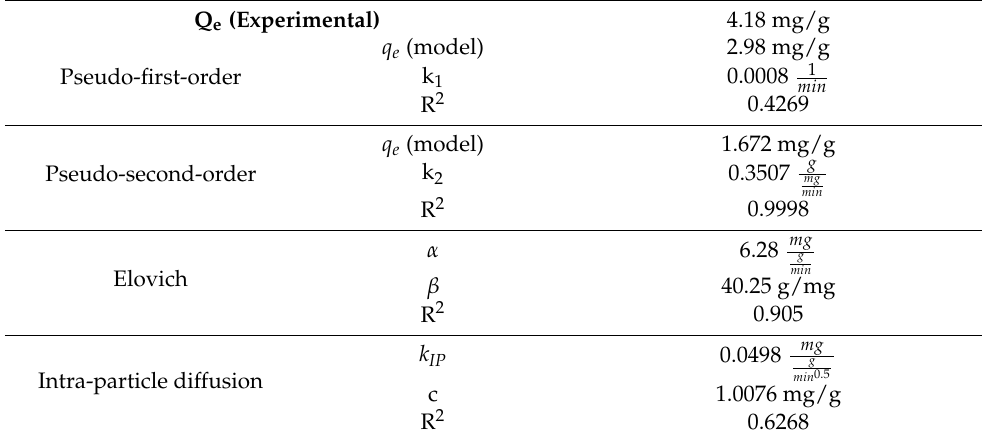
Table 5. Kinetic model parameters and correlation factors of the tested models on Mo adsorption by the CDC.